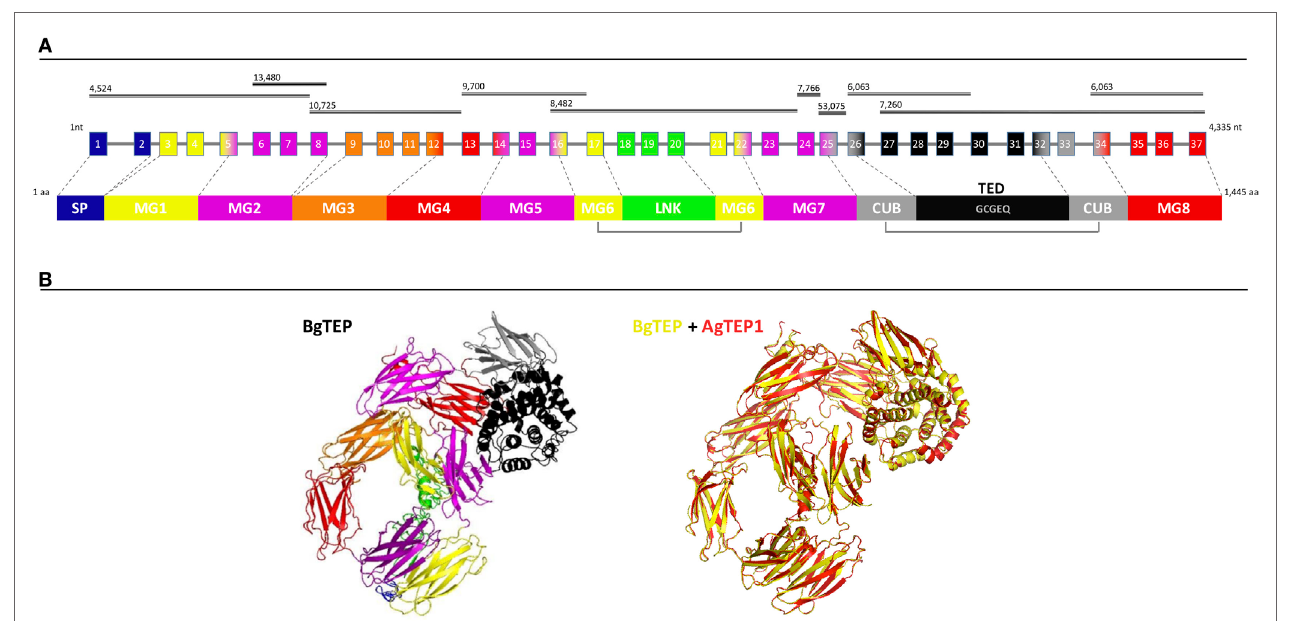
FigUre 1 | BgTEP organization. (a) Schematic representation of BgTEP sequence organization. The top black lines correspond to Biomphalaria glabrata genome scaffolds assigned with their corresponding scaffold numbers. The center part is a schematic of the exon/intron organization of BgTEP gene. The squares represent exons, the lines for introns, the number corresponds to the exon number, and finally their associated color corresponds to the different protein domain encoded that mapped on three-dimensional (3D) structure. The lower part corresponds to the schematic domain arrangement of BgTEP protein. The signal peptide (SP) domain is represented in blue followed by macroglobulin domain 1 (MG1) in yellow, MG2 in magenta, MG3 in orange, MG5 (magenta), MG6 (yellow), linker domain (LNK) (green), MG7 (magenta), CUB (gray), thioester domain (TED) with conserved motif (GCGEQ) in black, and MG8 in red. (B) Overview of 3D BgTEP structure predicted by I-Tasser software, using Anopheles gambiae TEP1 (AgTEP1) as reference. The colored domains of the BgTEP protein match the color of the corresponding encoding exon. Despite a low similarity at the amino-acid level (29%), a high conserved spatial conformation (TM-score = 0.98) was observed between BgTEP (yellow) and TEP1 of A. gambiae